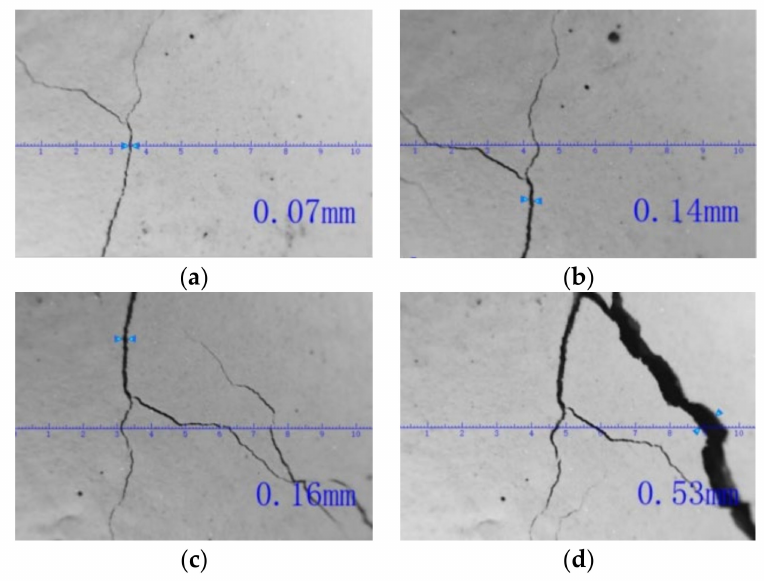
Figure 22. Development of No. 5 crack under di ff erent loads ( a ) 80 kN ( b ) 200 kN ( c ) 240 kN ( d ) 280 kN.